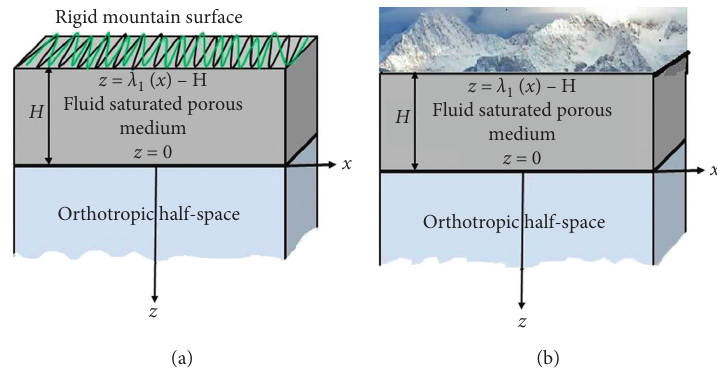
Figure 1: Model-I: medium of the propagation under rigid mountain